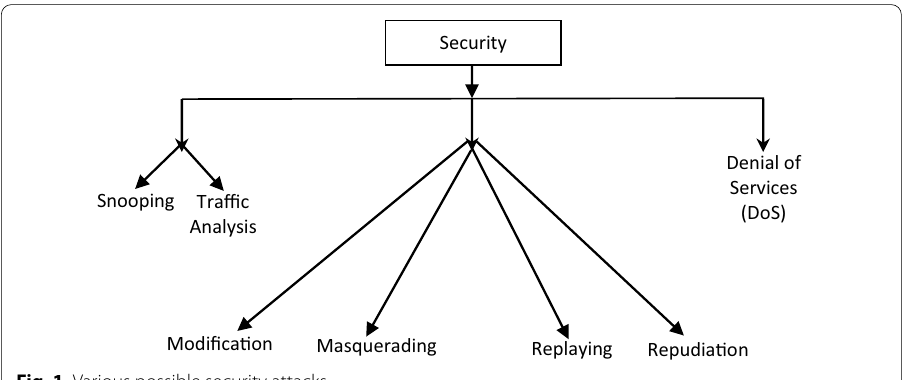
Fig. 1 Various possible security